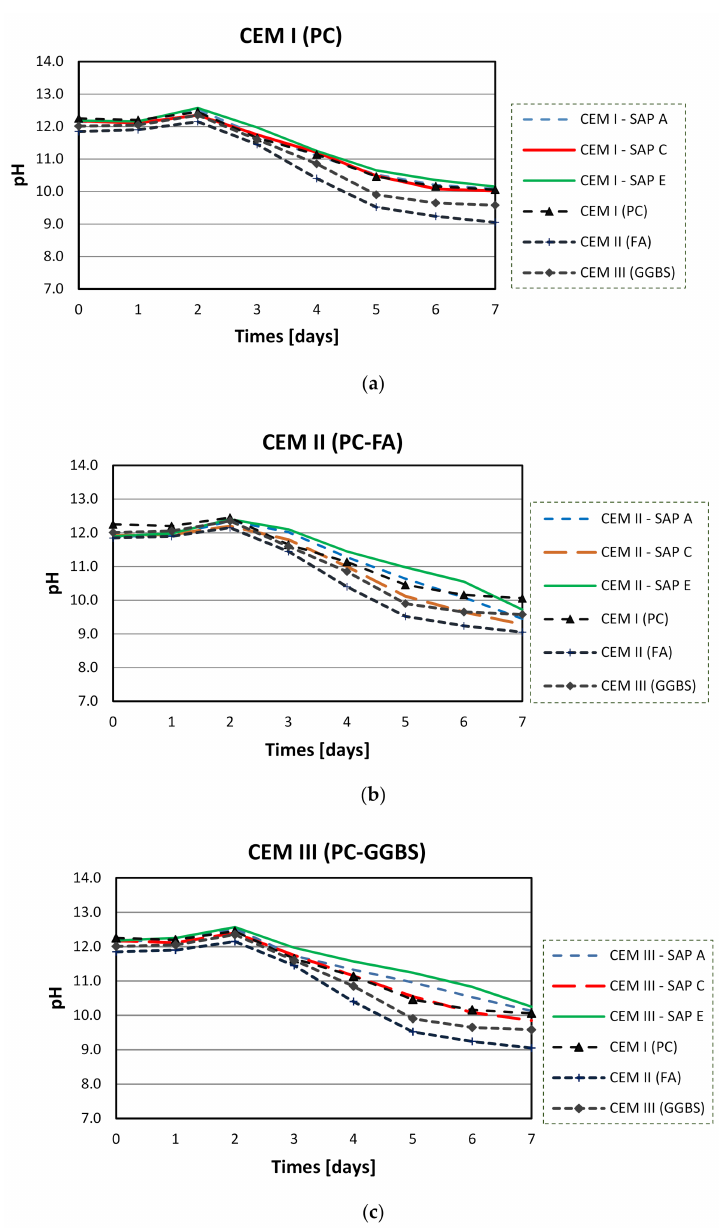
Figure 11. pH analysis of SAP solutions in CEM I (PC) ( a ), CEM II (PC-FA) ( b ), CEM III (PC-GGBS) ( c )